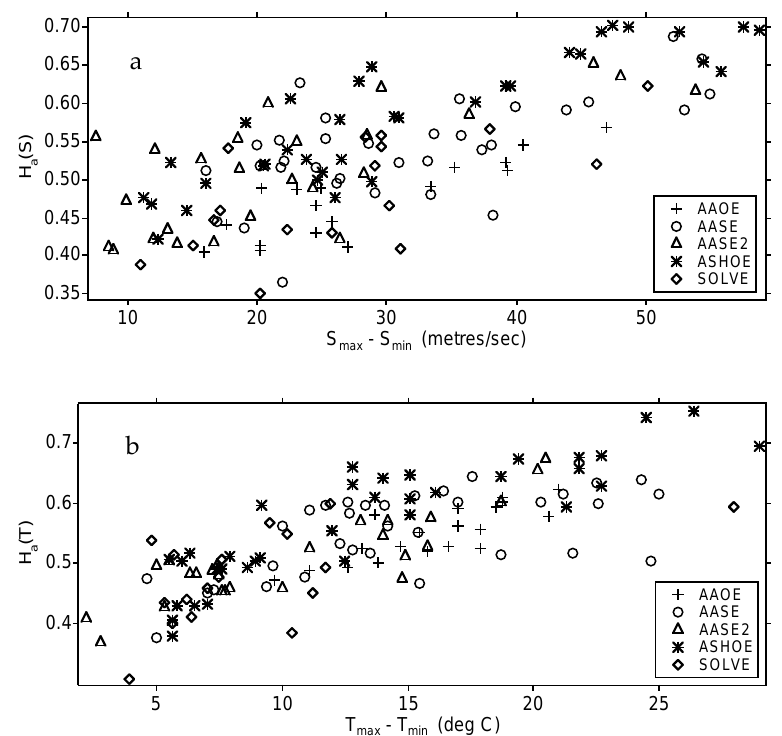
Figure 3. ( a ) Scaling exponent H for the horizontal wind speed obtained from the ER-2 plotted against the difference between the maximum and minimum wind speeds measured by the aircraft in crossing the polar night jet stream. ( b ) The same flights, but for temperature. For both wind speed and temperature, there is a positive correlation between H and traditional measures of jet stream strength, the horizontal gradients of wind speed and